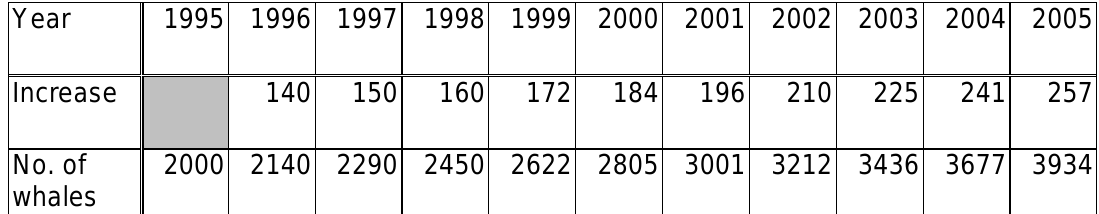
Table 8a. Mathematical model of whales in South African waters